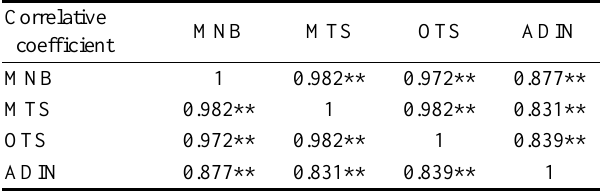
Table 5. The standard error of all of the parameter estimates of regression equation